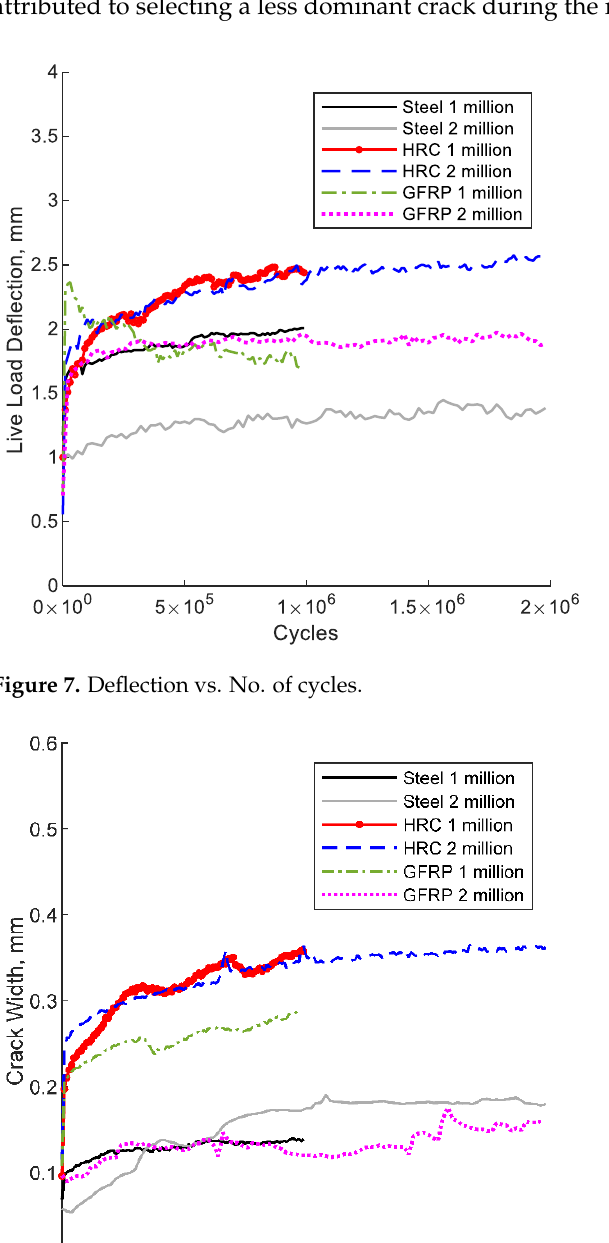
Figure 8. Crack width vs. No. of cycles.